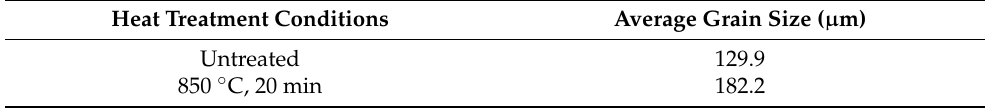
Figure 2. Optical microscope images after etching treatment. ( a ) Untreated; ( b ) heat-treated at 850 °C for 20 min. Table 3. Average grain size estimated from Figure 2.